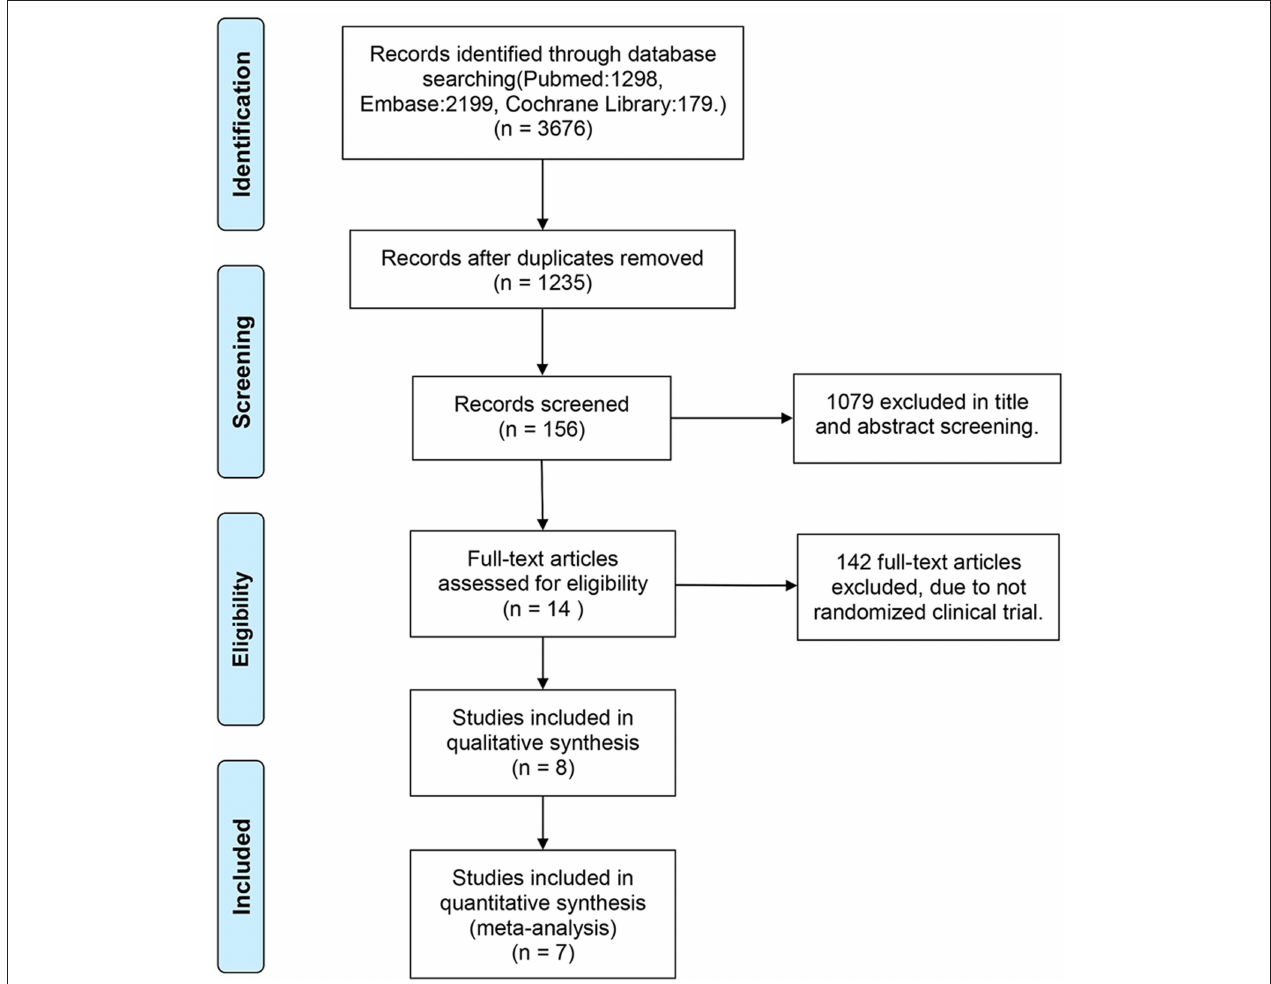
FIGURE 1 | Study flow